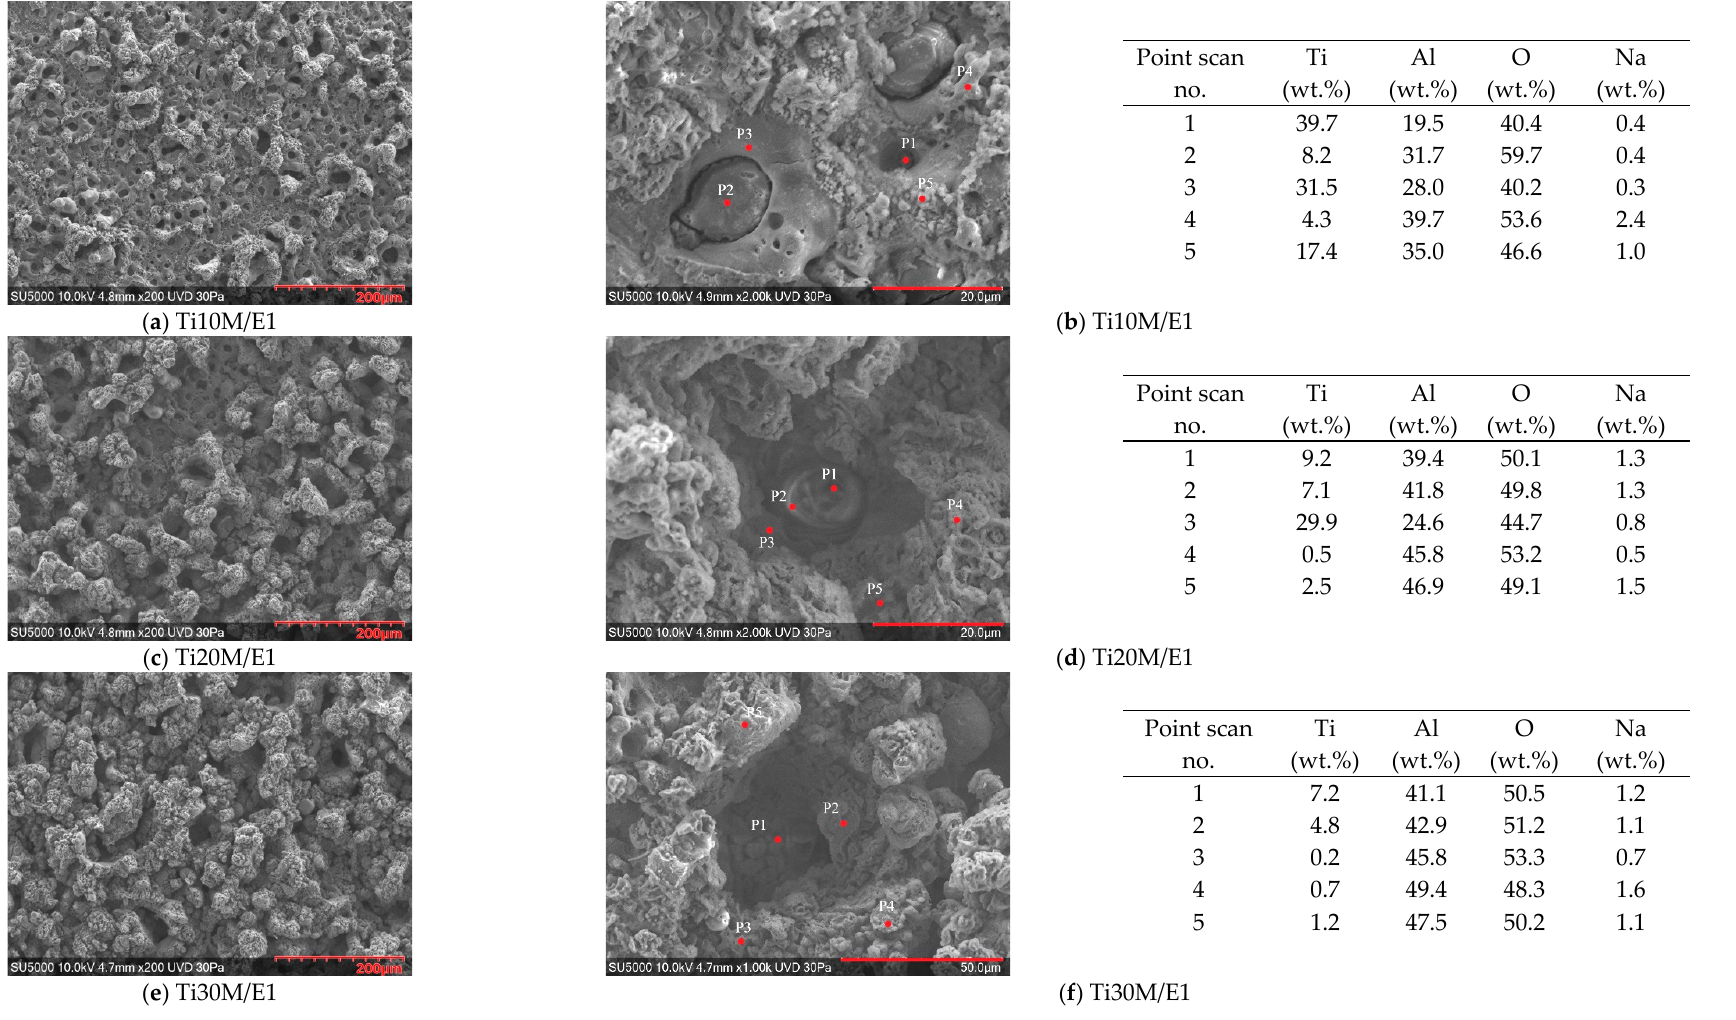
Figure 5. SEM images of the layers grown in E1 electrolyte after 10, 20 and 30 min treatment period: low magnification ( a , c , e ); high magnification and EDS analysis points ( b , d , f ); point element mass concentrations